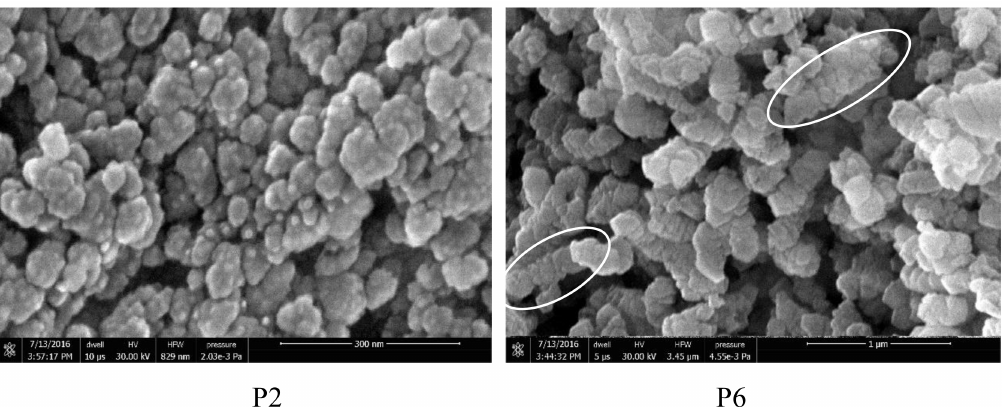
Figure 4. Field Emission (FE) SEM micrographs of the products from runs P2 and P6. Circles indicate “chain-like” submicrometric aggregates.